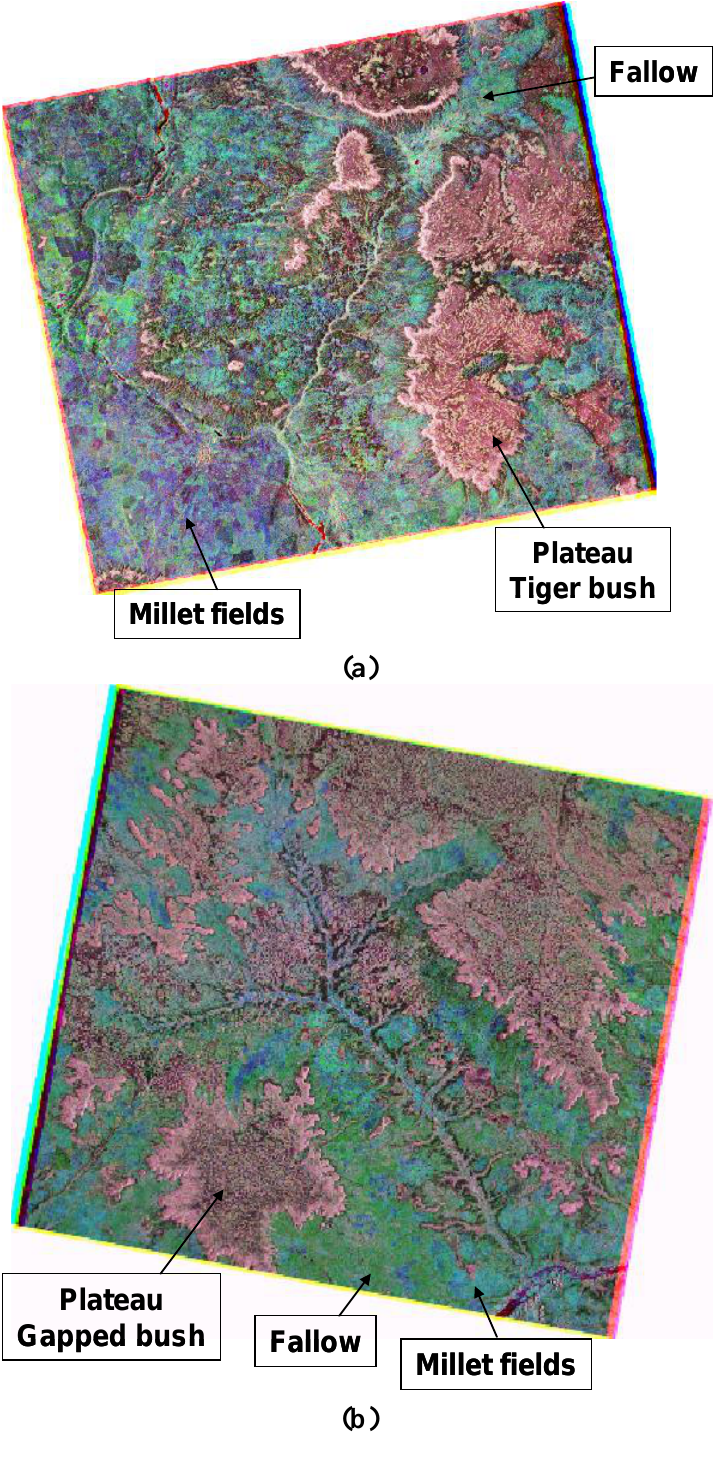
Figure 3. TerraSAR images on Banizoumbou and Tamou. The size of each study site is 10 km × 10 km. (a) Banizoumbou, RGB = 29 May, 14 August and 08 October 2009; (b) Tamou, RGB = 04 June, 29 July and 14 October